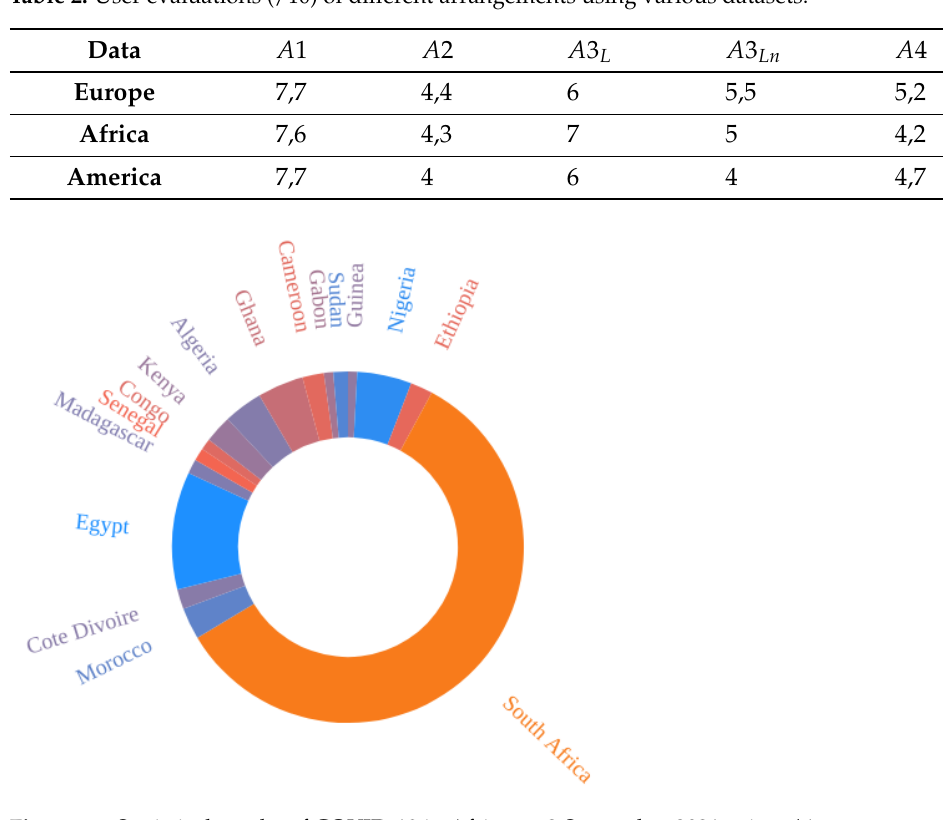
Figure 15. Statistical results of COVID-19 in Africa on 2 September 2021 using A 1.